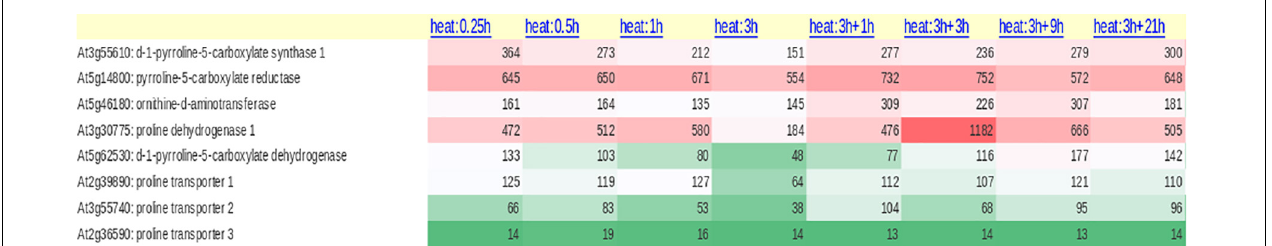
FIGURE 2 | Expression of proline biosynthetic pathway genes (anabolic and catabolic) both from glutamate and ornithine and proline transporters (ProT) under diverse temperature regimes in Arabidopsis thaliana .